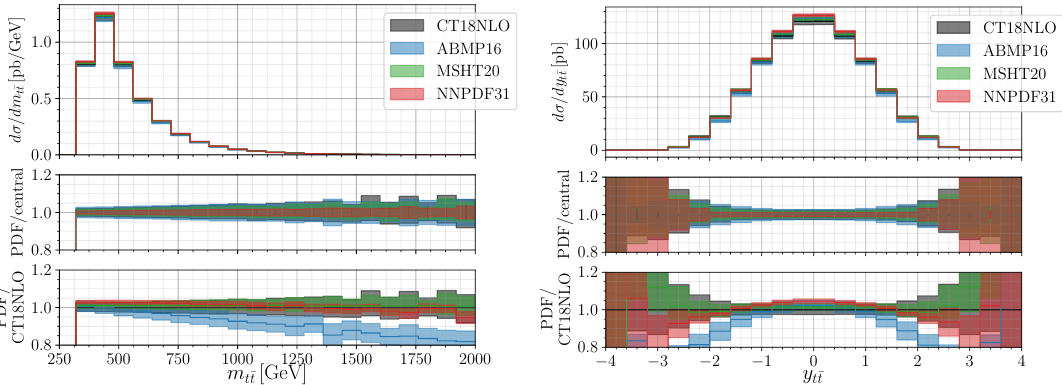
Figure 23 . Same as figure 21, but for the m